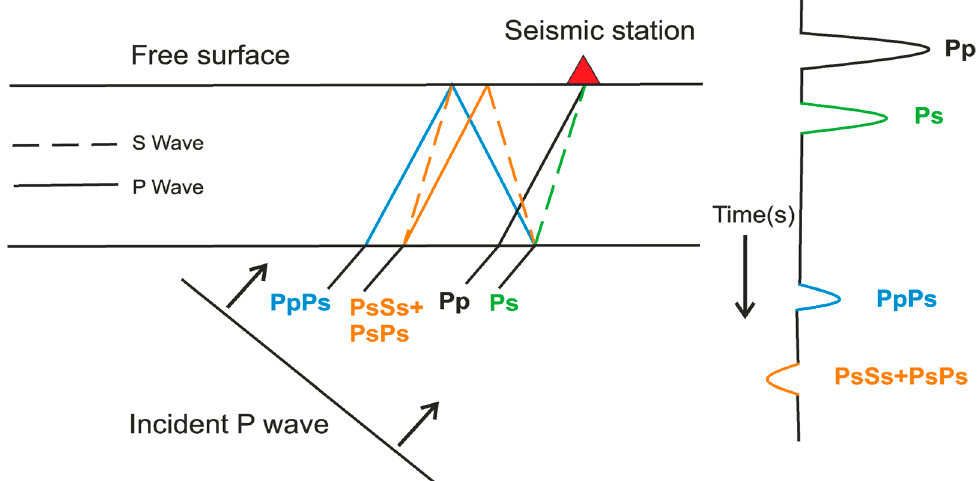
Figure 3. Schematic configuration of the main ray paths corresponding to the phases used for the H-k stacking. The solid and dashed lines represent the P- and S-waves, respectively.